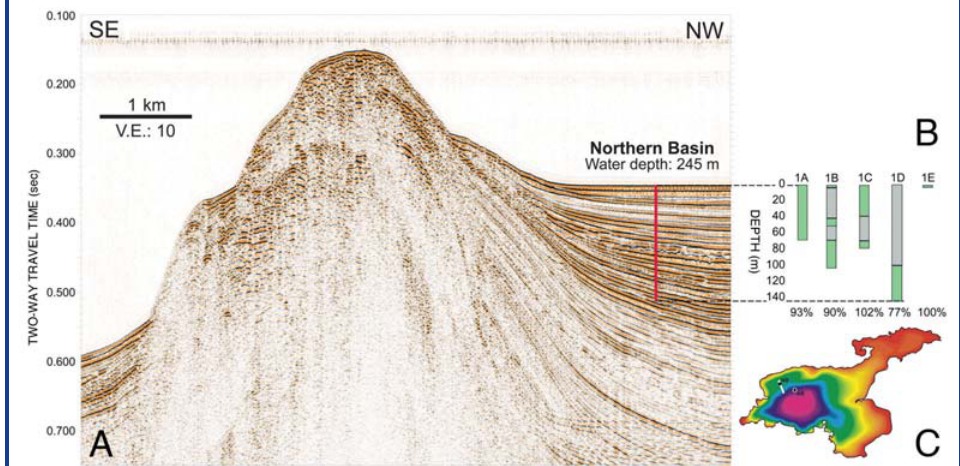
Figure 4. [A] S eismic line crossing the Northern Basin site. [B] Green areas show the cored sections of the multiple holes 1A–1D; 1E is the gravity short core. The numbers give the recovery of the individual holes